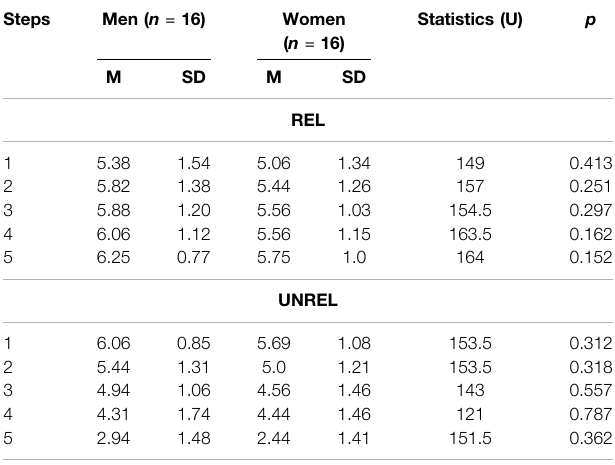
TABLE 2 | Results of men vs. women trust comparisons over the fi ve steps. No statistically signi fi cant difference has been detected. Steps Men ( n = 16) Women ( n =